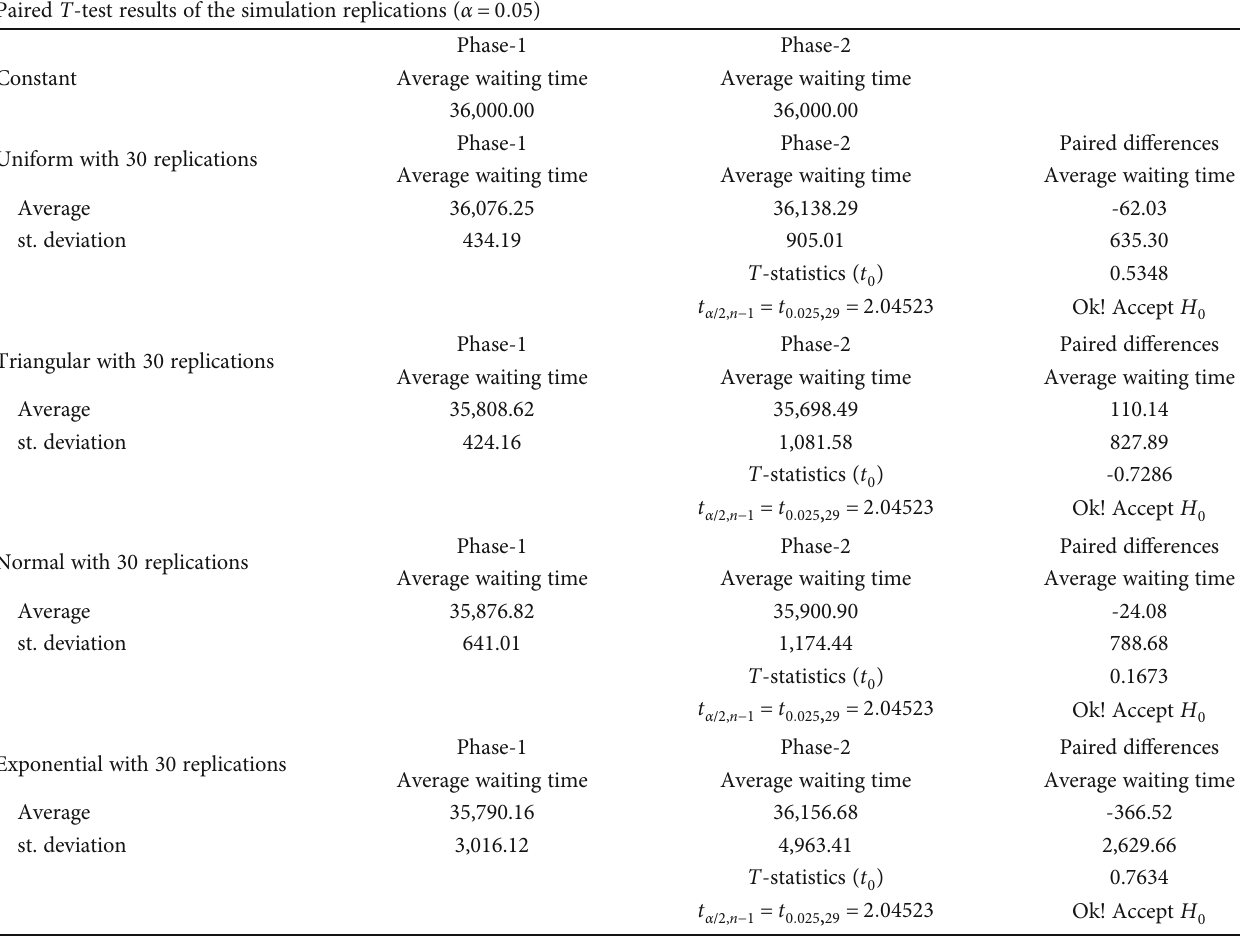
Table 5: Results of hypothesis testing for constructed paired T -tests to compare phase-1 and phase-2 average waiting times for four interarrival distributions: uniform, triangular, normal, and exponential. Mean interarrival rates for all distributions in phase-2 are 100 tertias. Paired T -test results of the simulation replications ( α = 0 : 05